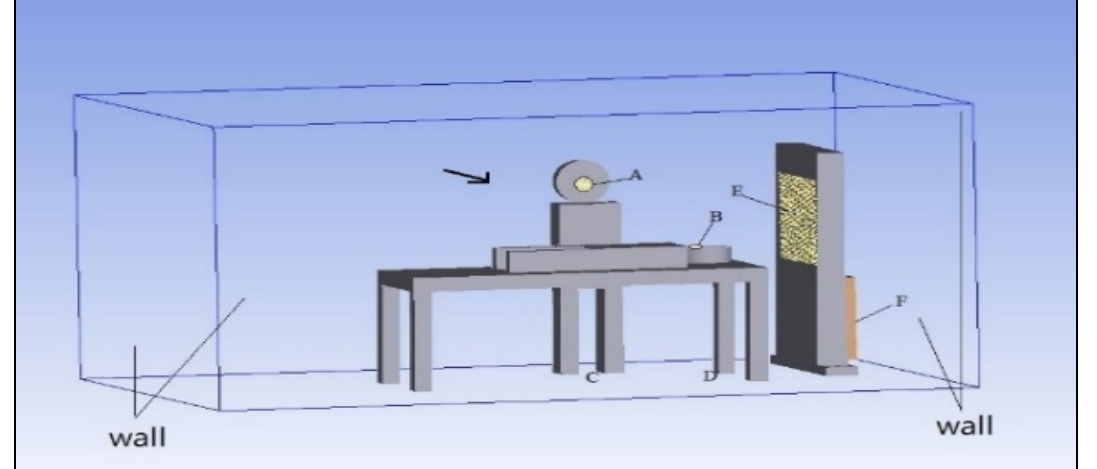
Figure 5. Air purifier in the ward. Figure 6 is a schematic diagram of the quarantine station (Case 3). The distance